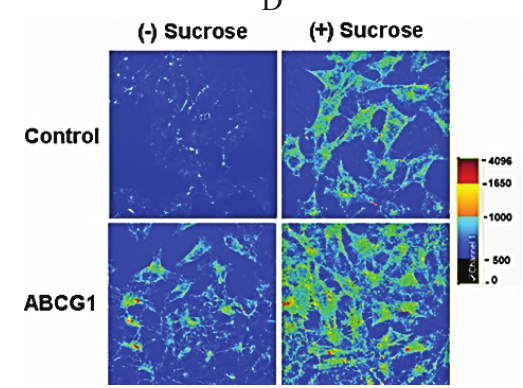
Figure 9. Cont. C